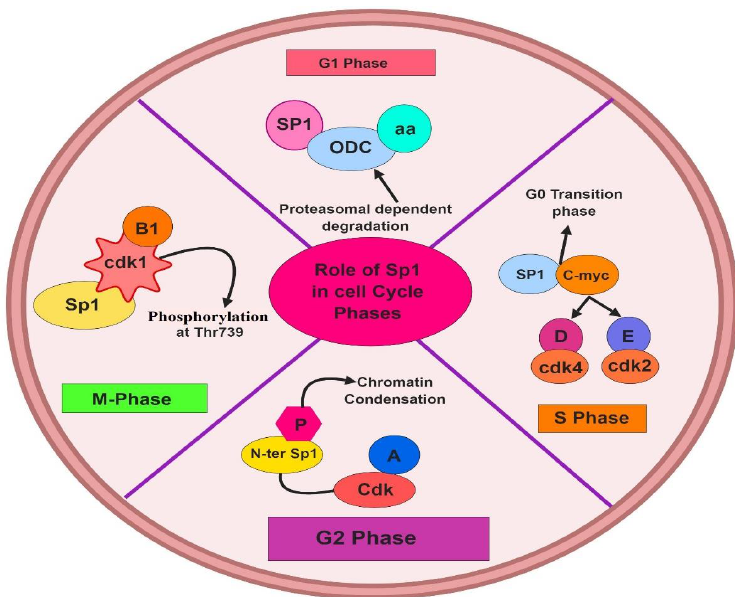
Figure 2. Role of Sp1 in the cell cycle. Improper functioning of the cell cycle and its checkpoints are